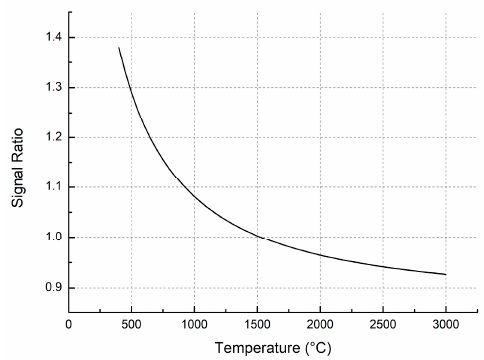
Figure 8. SR trend versus T for the best filter